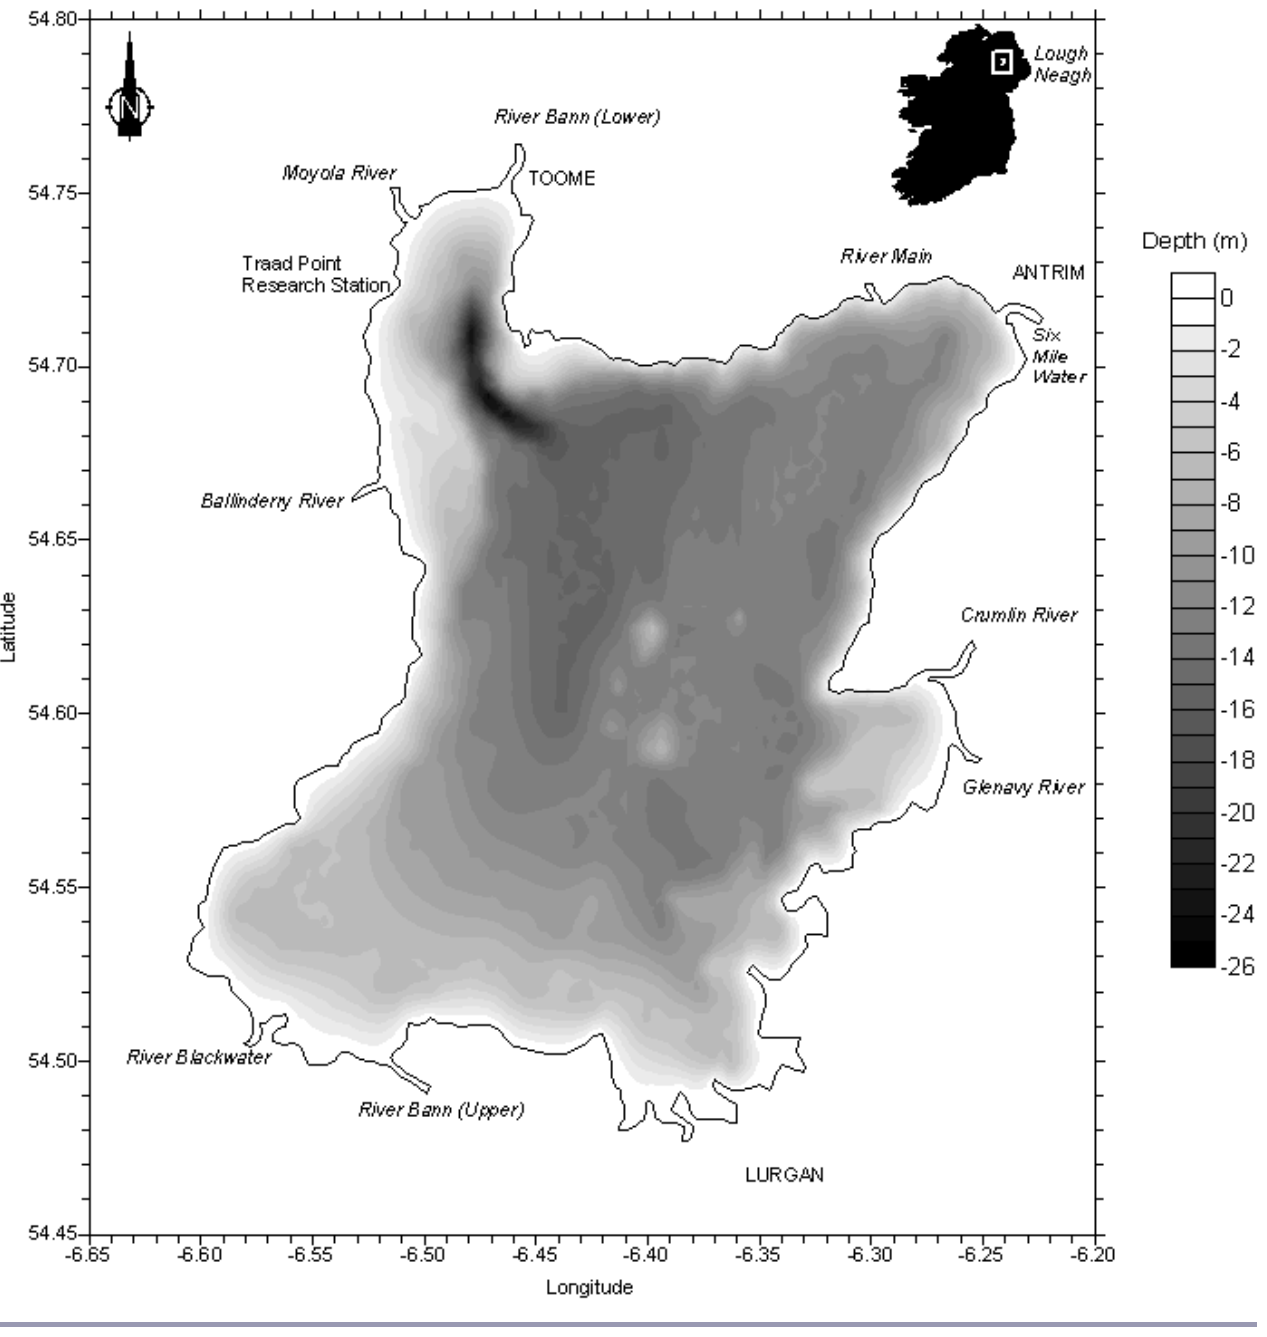
Fig. 1. Location map and two-dimensional contour plot (bathymetric variation) of Lough Neagh, located in the north of Ireland. Place names and geographical features cited in the main text are plotted around the shoreline of the